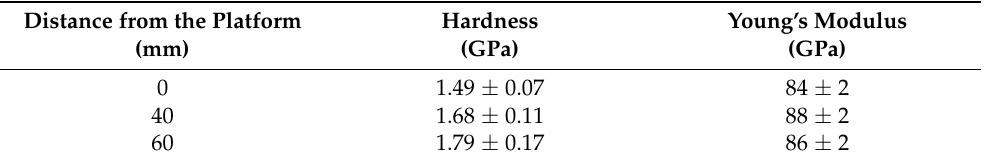
Table 3. Evolution of hardness and Young’s modulus as a function of the distance from the building platform (Area 1).